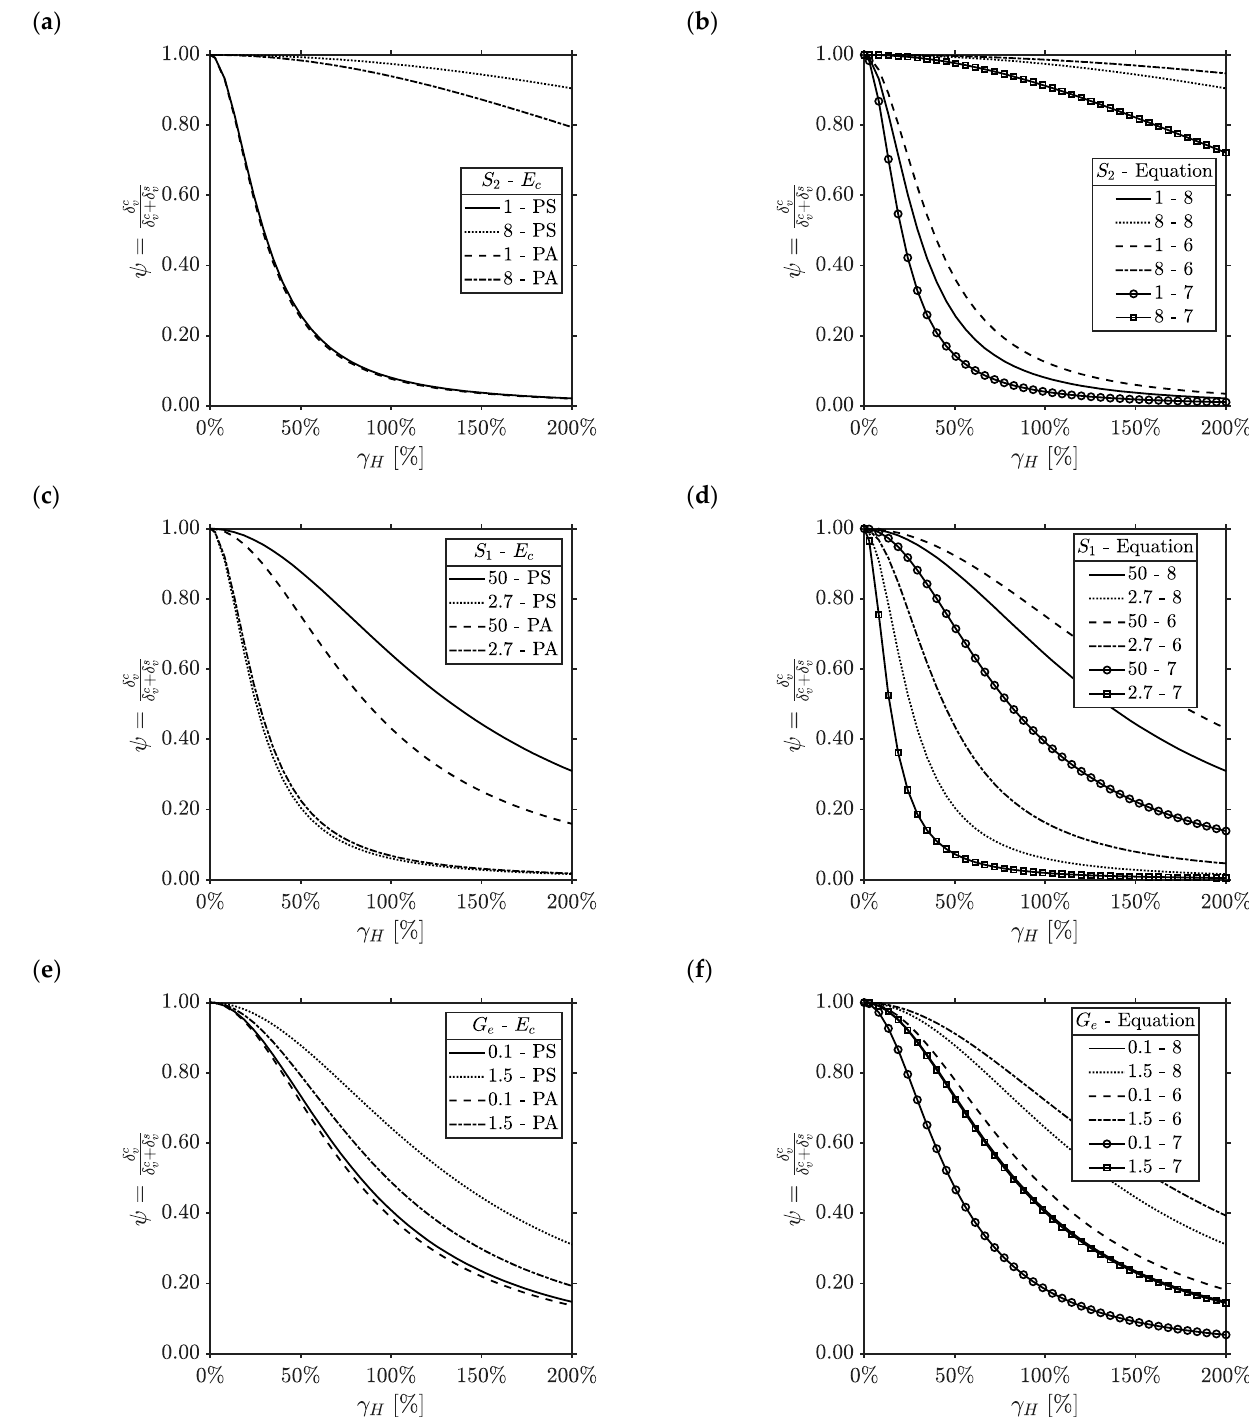
Figure 3. Range of variability of the ψ function with the horizontal deformation from maximum to minimum: ( a , b ) secondary shape factors; ( c , d ) primary shape factor; ( e , f ) shear modulus of the rubber.